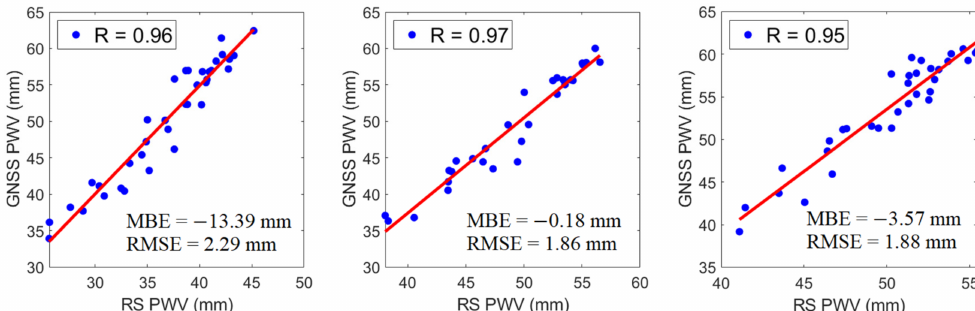
Figure 4. The correlations of monthly means of RS PWV and GNSS PWV in ( a ) Tanay and PIMO, ( b ) Legaspi and PLEG, and ( c ) Puerto Princesa and PPPC from 2015 to 2017. MBE and RMSE values for each datum are also